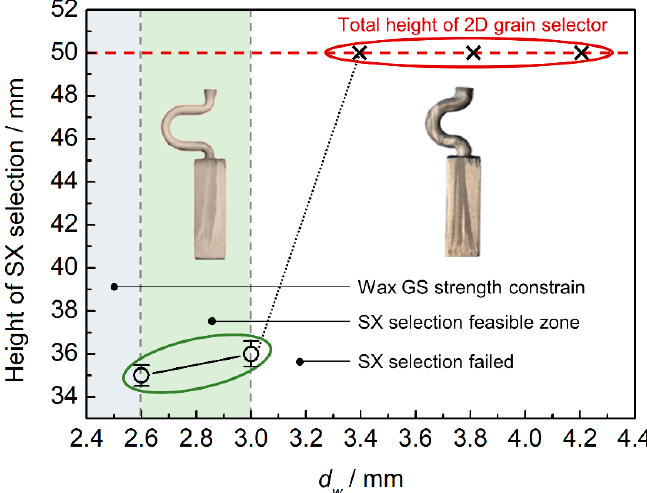
Figure 4. Experimentally observed heights of SX position versus selector thickness ( d w ).